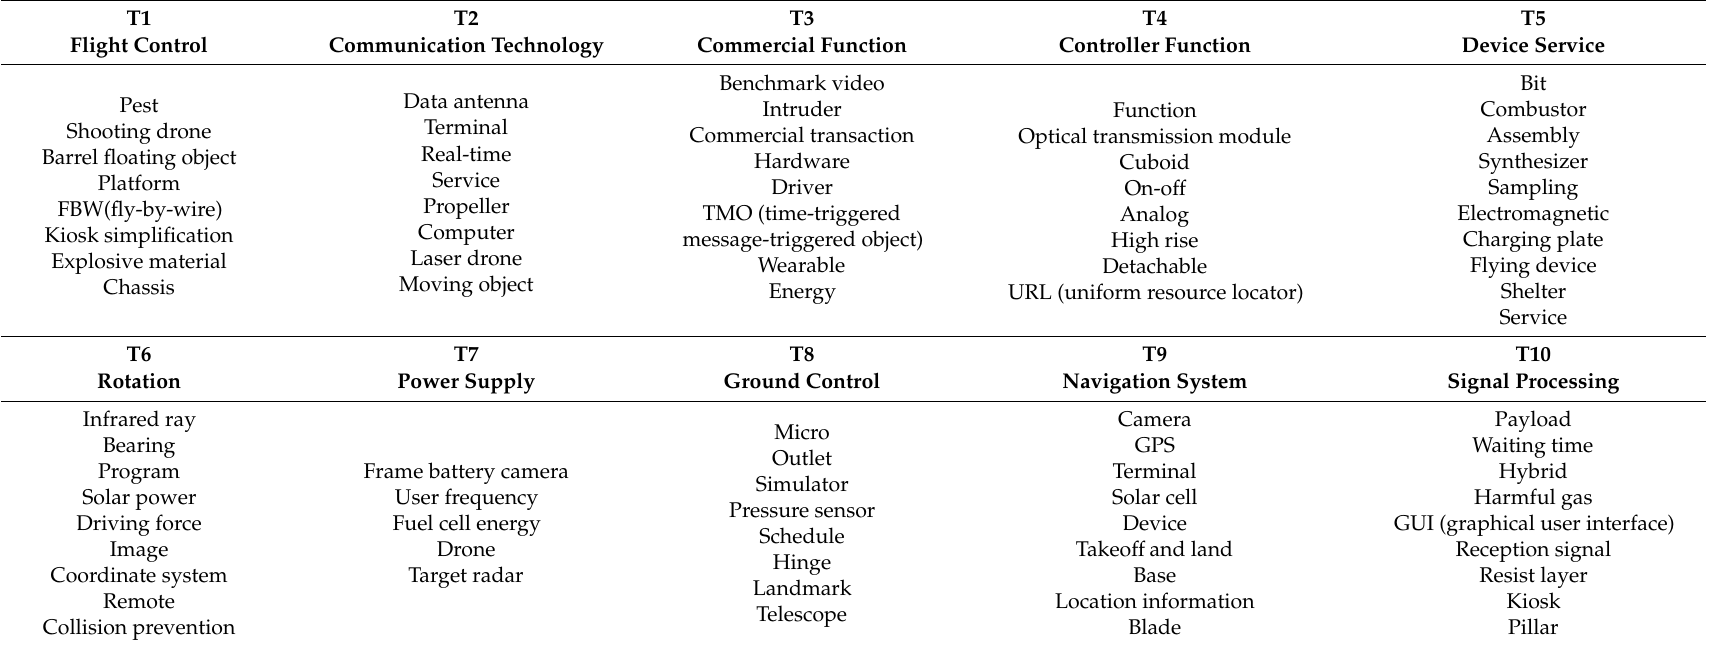
Table 1. Extraction of keywords in unmanned aerial vehicles